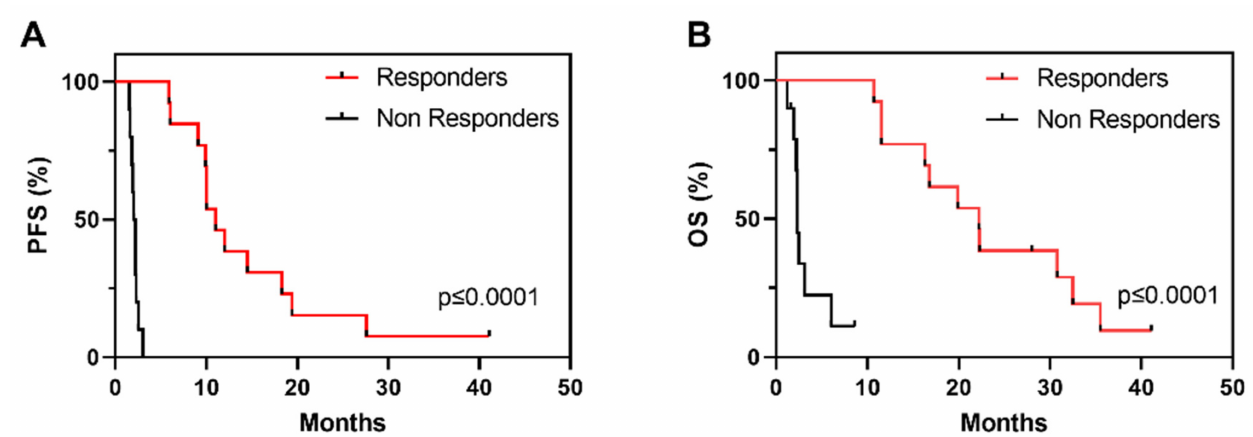
Figure 1. Kaplan–Meier survival curves showing progression free survival ( A ) (PFS) and overall survival (( B ), OS) in R and NR patients in the study series to vinflunine treatment; p -Values provided by log rank